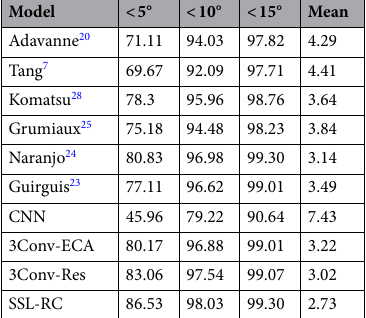
Table 1. Ration of correct predictions and Mean localization error comparisons.